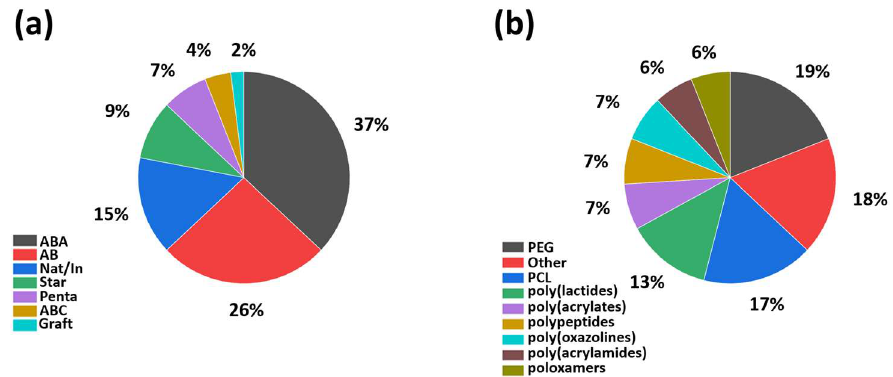
Figure 17. ( a ) Pie chart of the different architectures of block copolymers investigated the last years, and ( b ) pie chart of the different polymers used in block copolymers in the last years.